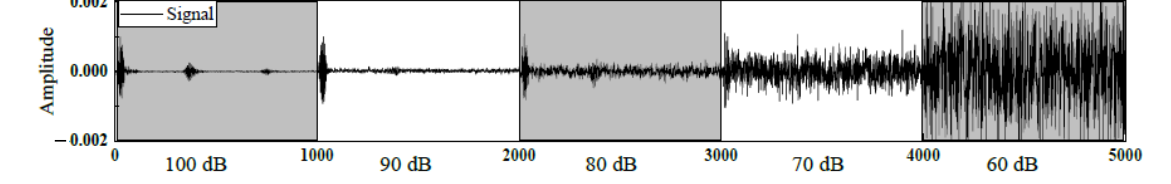
Figure 6. Received signals at different noise levels.